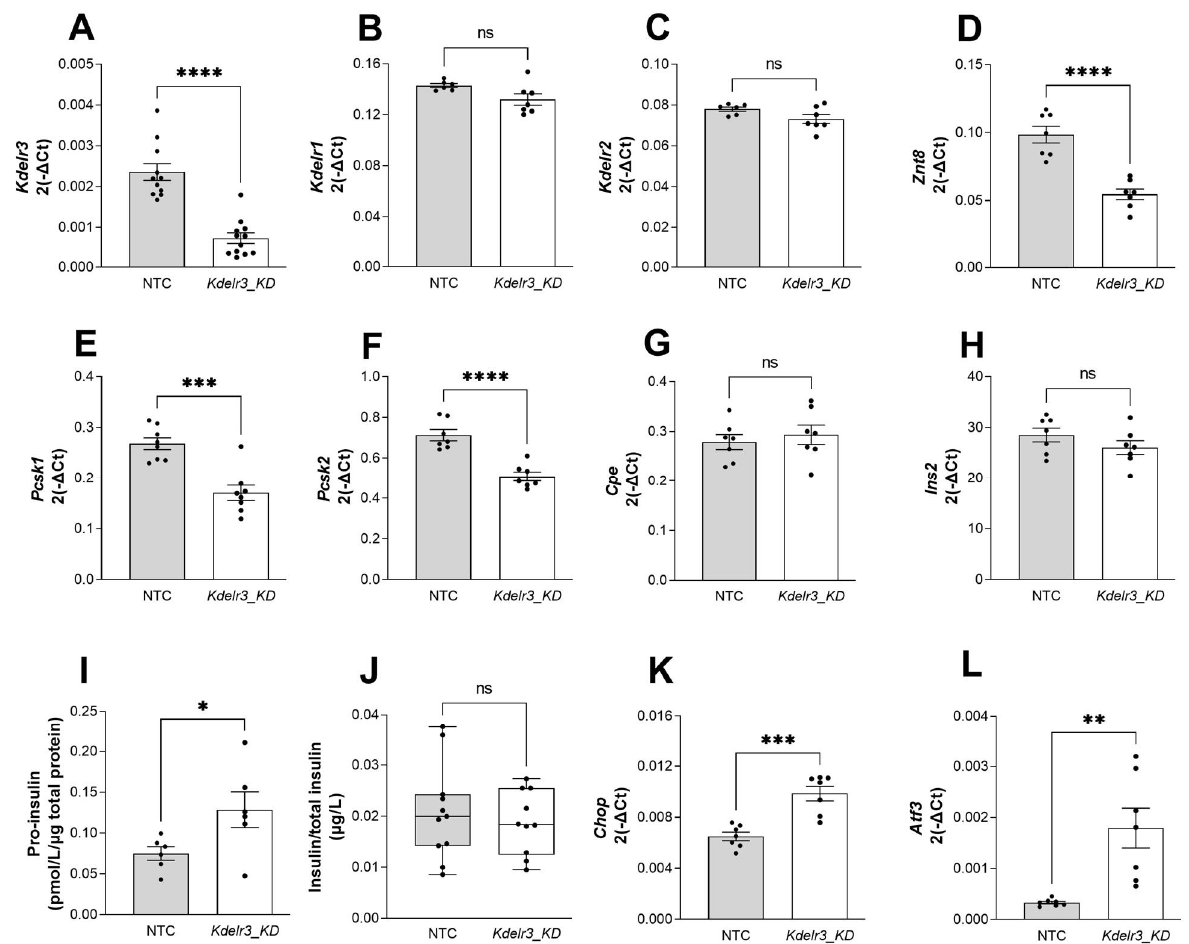
Figure 7. Effect of Kdelr3 Knockdown in MIN6 insulinoma cells. Quantitative real-time PCR of Kdelr 3 ( A ), Kdelr1 ( B ), Kdelr2 ( C ), Znt8 ( D ), Pcsk1 ( E ), Pcsk2 ( F ), Cpe ( G ) and In2 ( H ). Pro-insulin in measured in MIN6 cell lysates ( I ), GSIS after 25 mM glucose treatment ( J ). Quantitative real-time PCR of Chop ( K ) and Atf3 ( L ). Kdelr3 knockdown cells were generated using a pool of siRNA. Data are presented as mean ± SEM and were analyzed by Students t test, * p < 0.05; ** p < 0.01; *** p <0.001; **** p < 0.0001; ns= non significant n = 5–12 independent experiments.